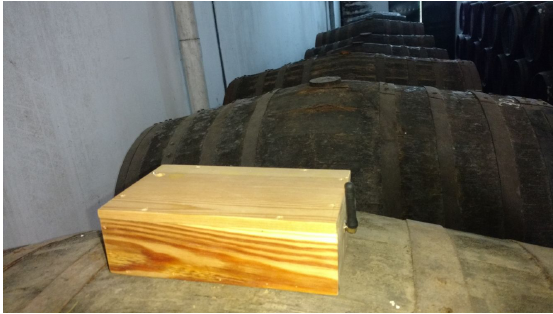
Figure 10. Smart cork installed in a winery based in Montemayor